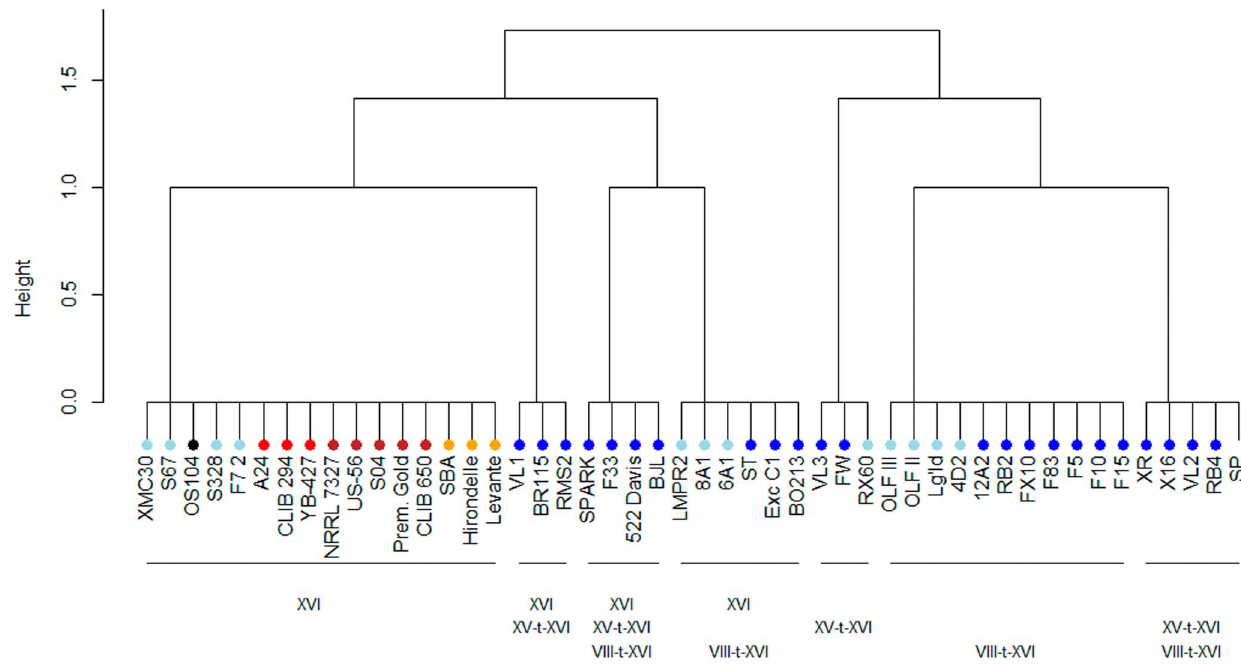
Figure 4. Distribution of translocations XV-t-XVI and VIII-t-XVI among industrial yeast on different origin. The Euclidian distance among 48 yeast strains according to the presence of the three allelic forms on chromosome XVI (nt-XVI, VIII-t-XVI, and XV-t-XVI) was calculated using the R program. The origin of each yeast strain used is coded by a color point. Light blue=grape isolates, dark blue=wine starters, black=natural isolate, red=distillery, brown=brewery, orange=bakery.